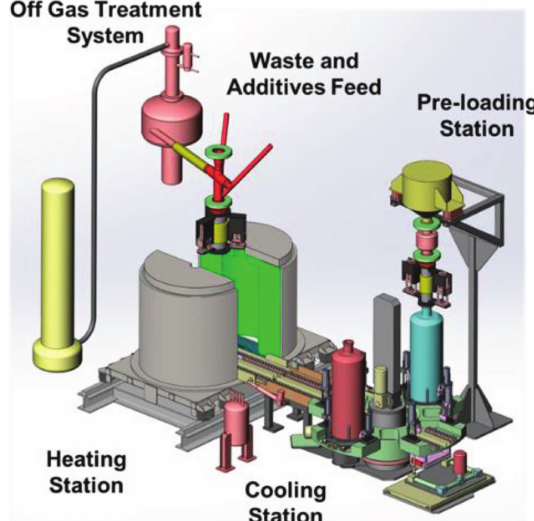
Fig. 1. Schematic diagram of the DEM&MELT process.